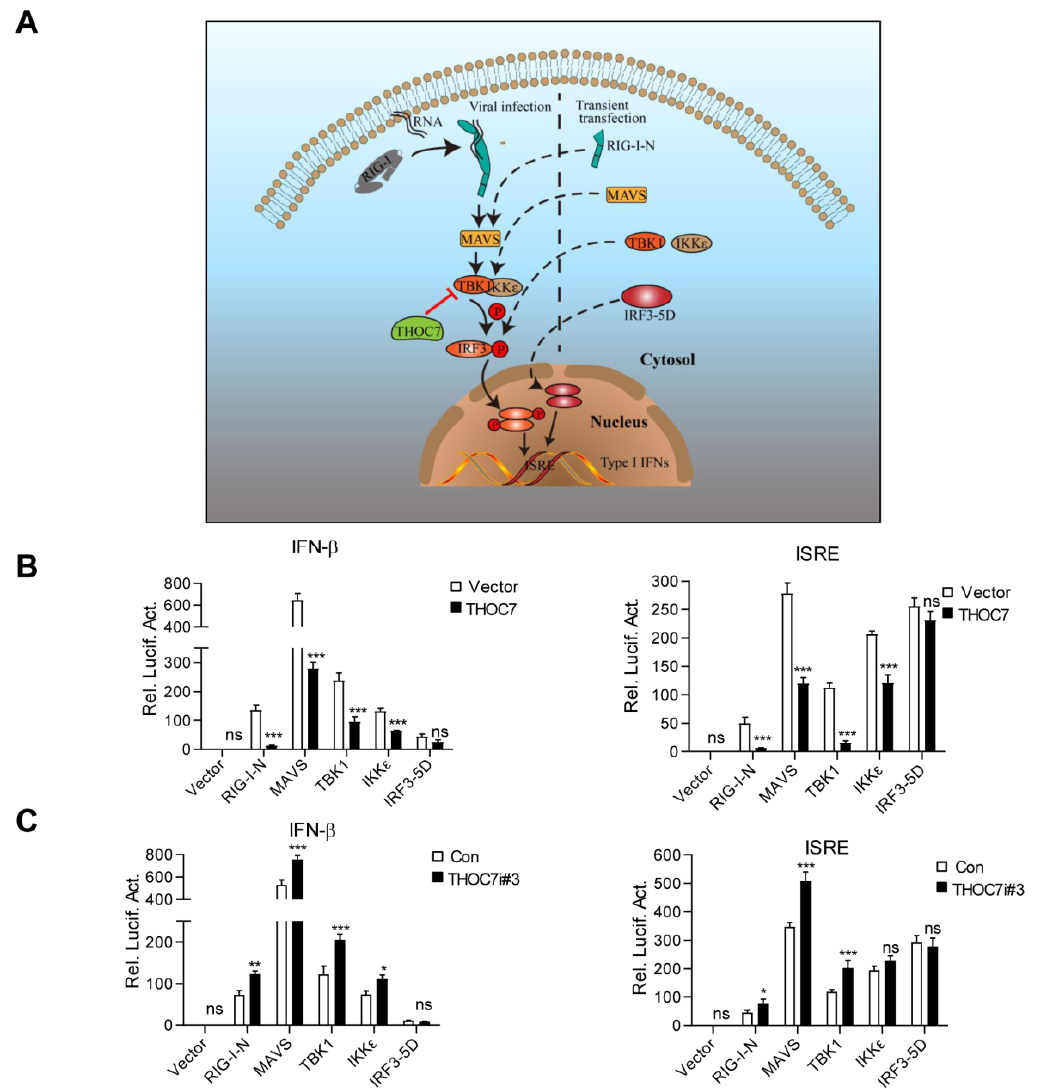
Figure 3. THOC7 regulates the RLR signaling pathway by targeting TBK1. ( A ) A simulation model of node-activated pathway for the role of THOC7 in regulating the RLR signaling pathway. Downstream signaling was activated by transfection of the activated form of signaling pathway molecules containing RIG-I-N, MAVS, TBK1, IKK ε , and IRF3-5D. ( B , C ) Effects of THOC7 overexpression or THOC7 knockdown on IFN β or ISRE activation mediated by various activated forms of signaling molecules. 293T cells were seeded into 24-well plates and transfected with IFN- β or ISRE luciferase reporter (100 ng/well), pRL-TK (50 ng/well), THOC7 expression vector (0.5 µ g, B), or THOC71 RNAi#3 constructs (0.5 µ g, C) together with indicated activated forms of signaling molecules. Cells were harvested and analyzed by dual-luciferase reporter assay. After transfection for 24 h, the relative luciferase activities were normalized based on pRL-TK control activities. Error bars indicate SD. n = 3. *, p < 0.05; **, p < 0.01; ***, p < 0.001; ns, no significant